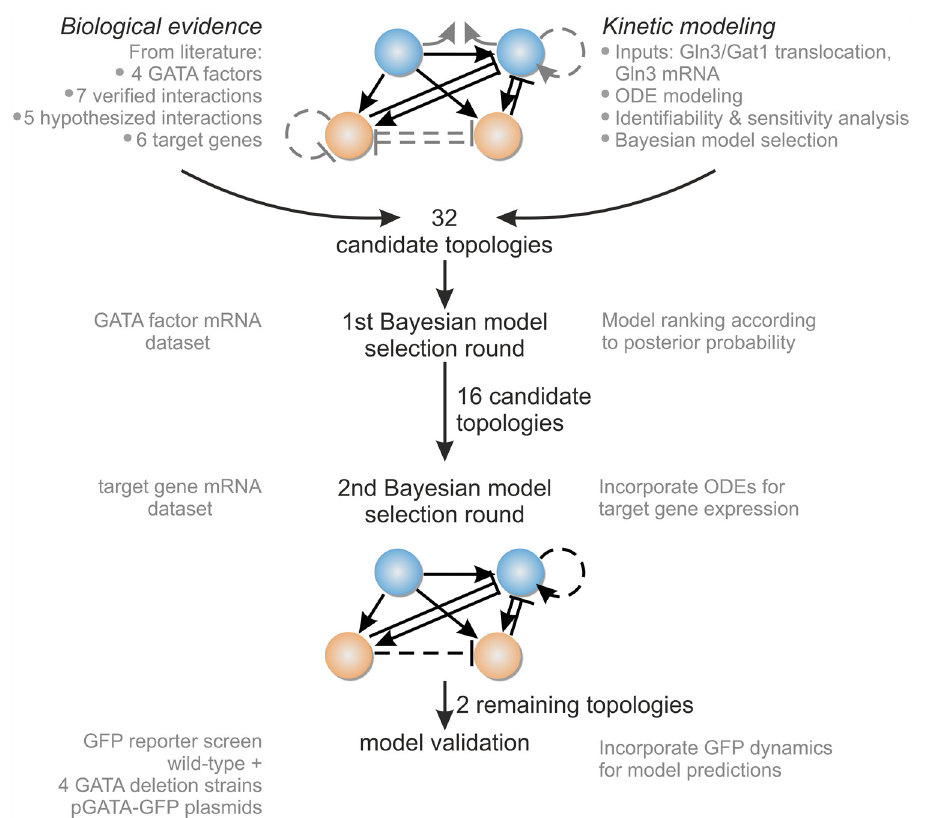
Fig 2. Model selection and validation